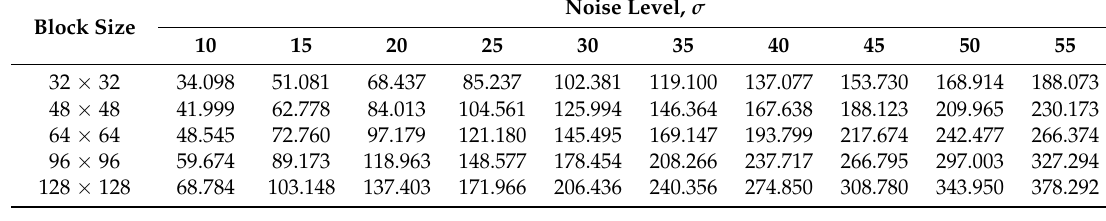
Table 1. The average P ( M ) values across a range of noise levels for different choices of block size. Block Size